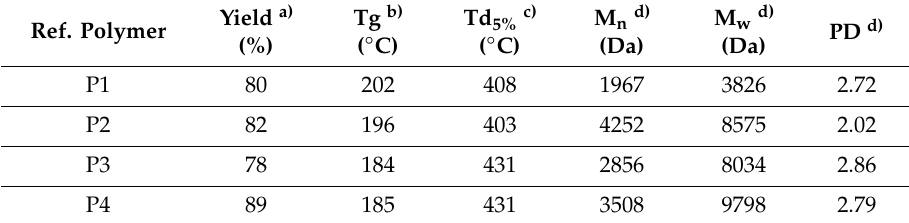
Table 1. Yields, thermal behaviors and molecular weights of resulting polymers